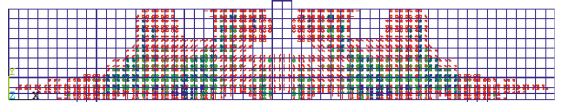
Figure 15: FE crack pattern at failure load for beam